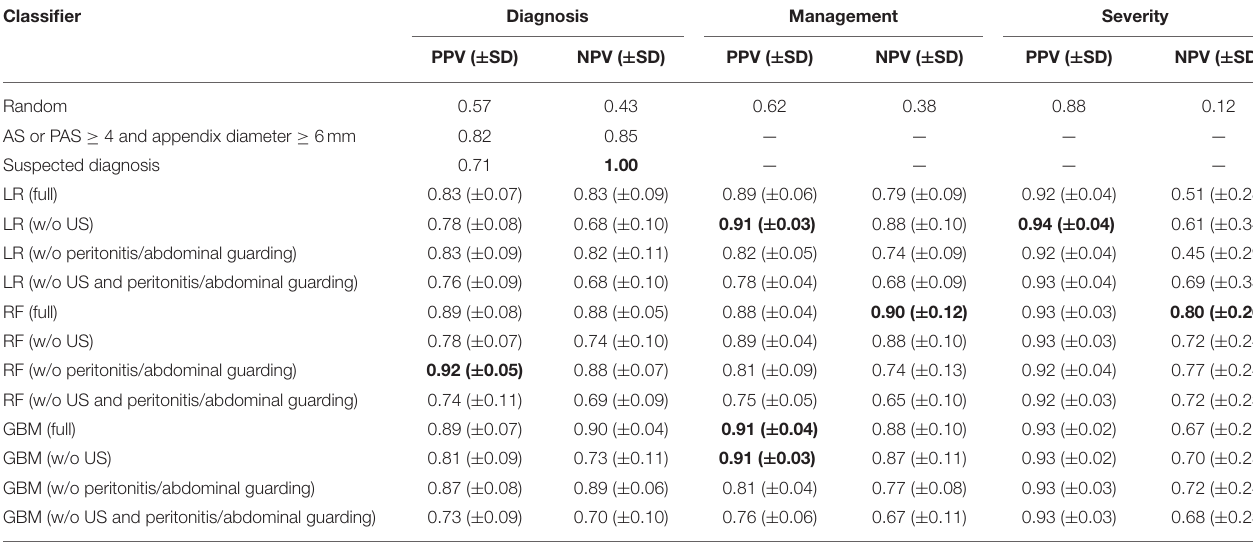
TABLE 5 | Ten-fold cross-validation results for logistic regression (LR), random forest (RF), and generalized boosted regression (GBM) models for predicting diagnosis, management, and